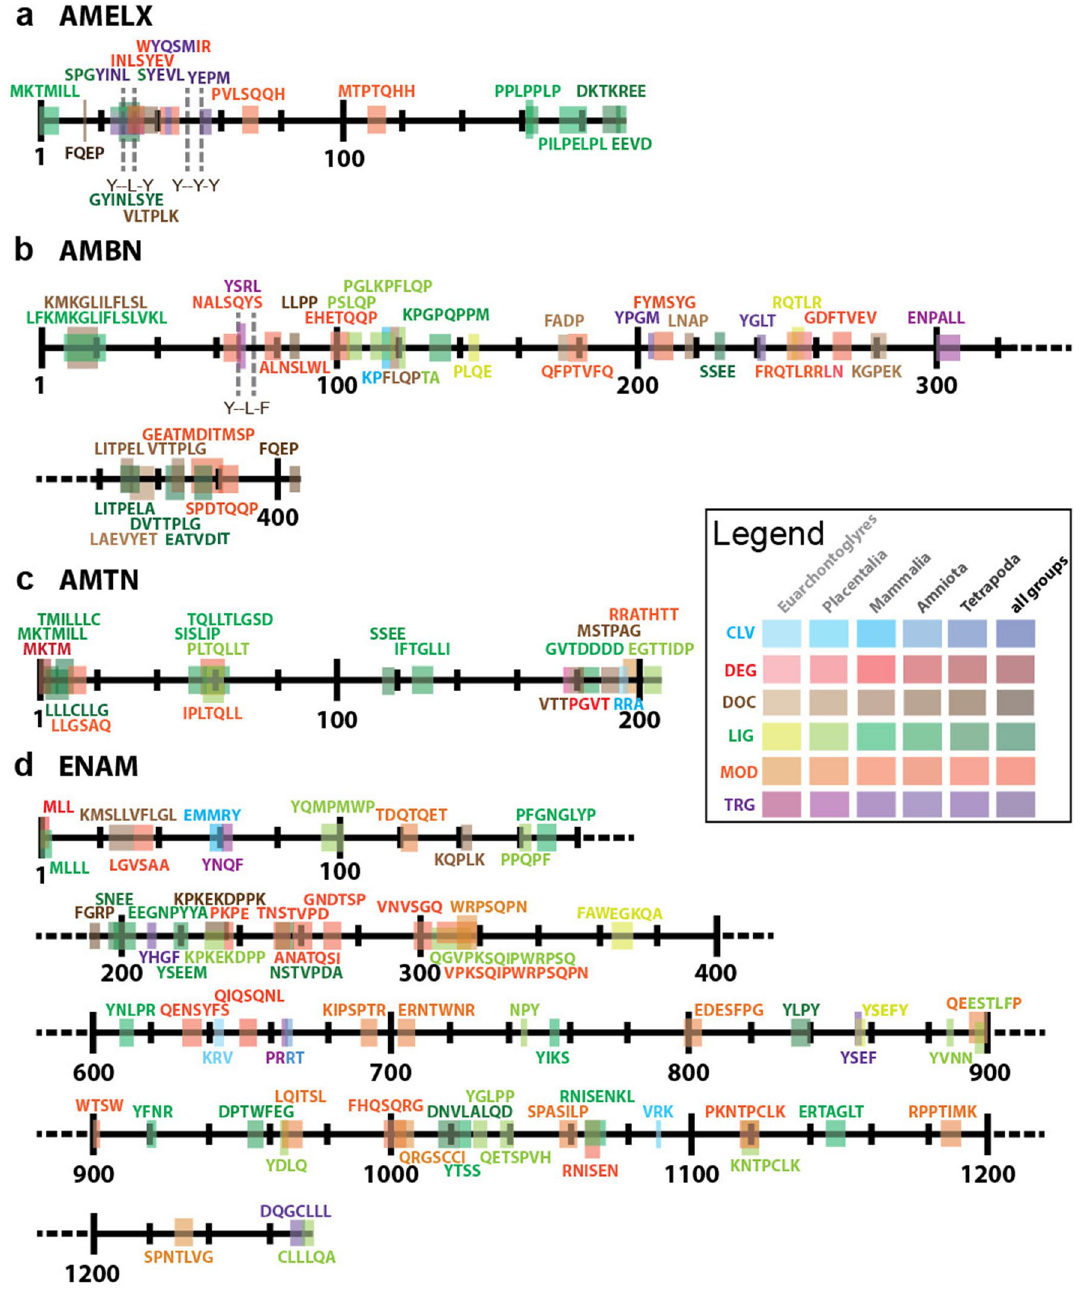
Figure 2. Identification of functional motives of EMPs. Detected functional motifs of AMELX ( a ), AMBN ( b ), AMTN ( c ), and ENAM ( d ). N-terminus to left, C-terminus to right. The position and motif structure corresponds to Mus musculus sequences for these proteins (AAB93765.1, BAA06546.1, NP_082069.1, and AAB94312.1). Color of the motif corresponds to the motif type (CLV = cleavage, DEG = degradation, DOC = docking, LIG = ligand, MOD = modifier, TRG = transport), while saturation to the minimal age of the motif, i.e. for how large taxonomical unit (Euarchontoglyres < Placentalia < Mammalia < Amniota < Tetrapoda < Sarcopterygii/Euteleostomi) is it common. The self-assembly motifs are highlighted in the AMELX (Y–L–Y; and Y–Y–Y) and AMBN (Y–L–F) structure. Detailed information about motifs in Supplementary table